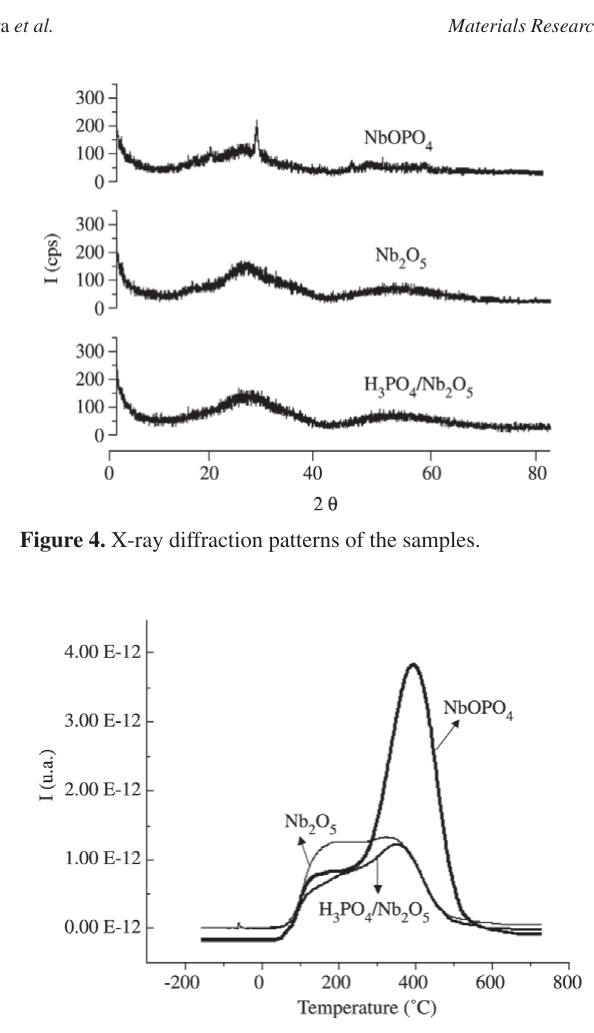
Figure 5. NH -TPD profiles of the prepared 3